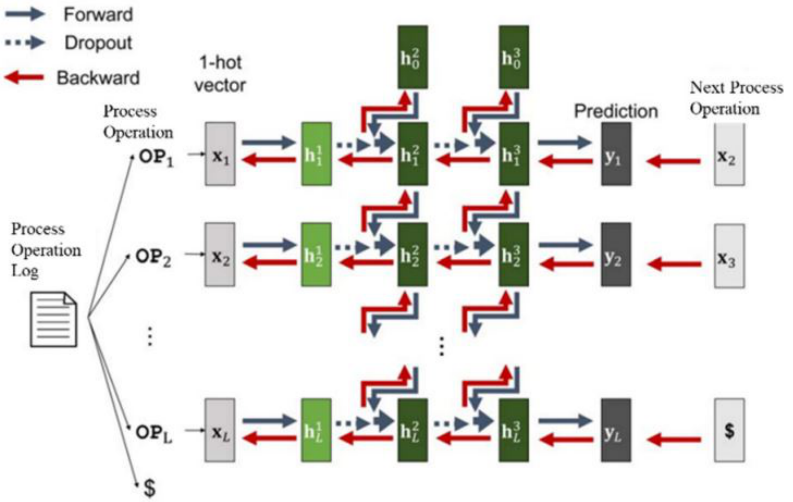
Figure 8. An RNN architecture for understanding malicious behaviour considering the process operations is presented